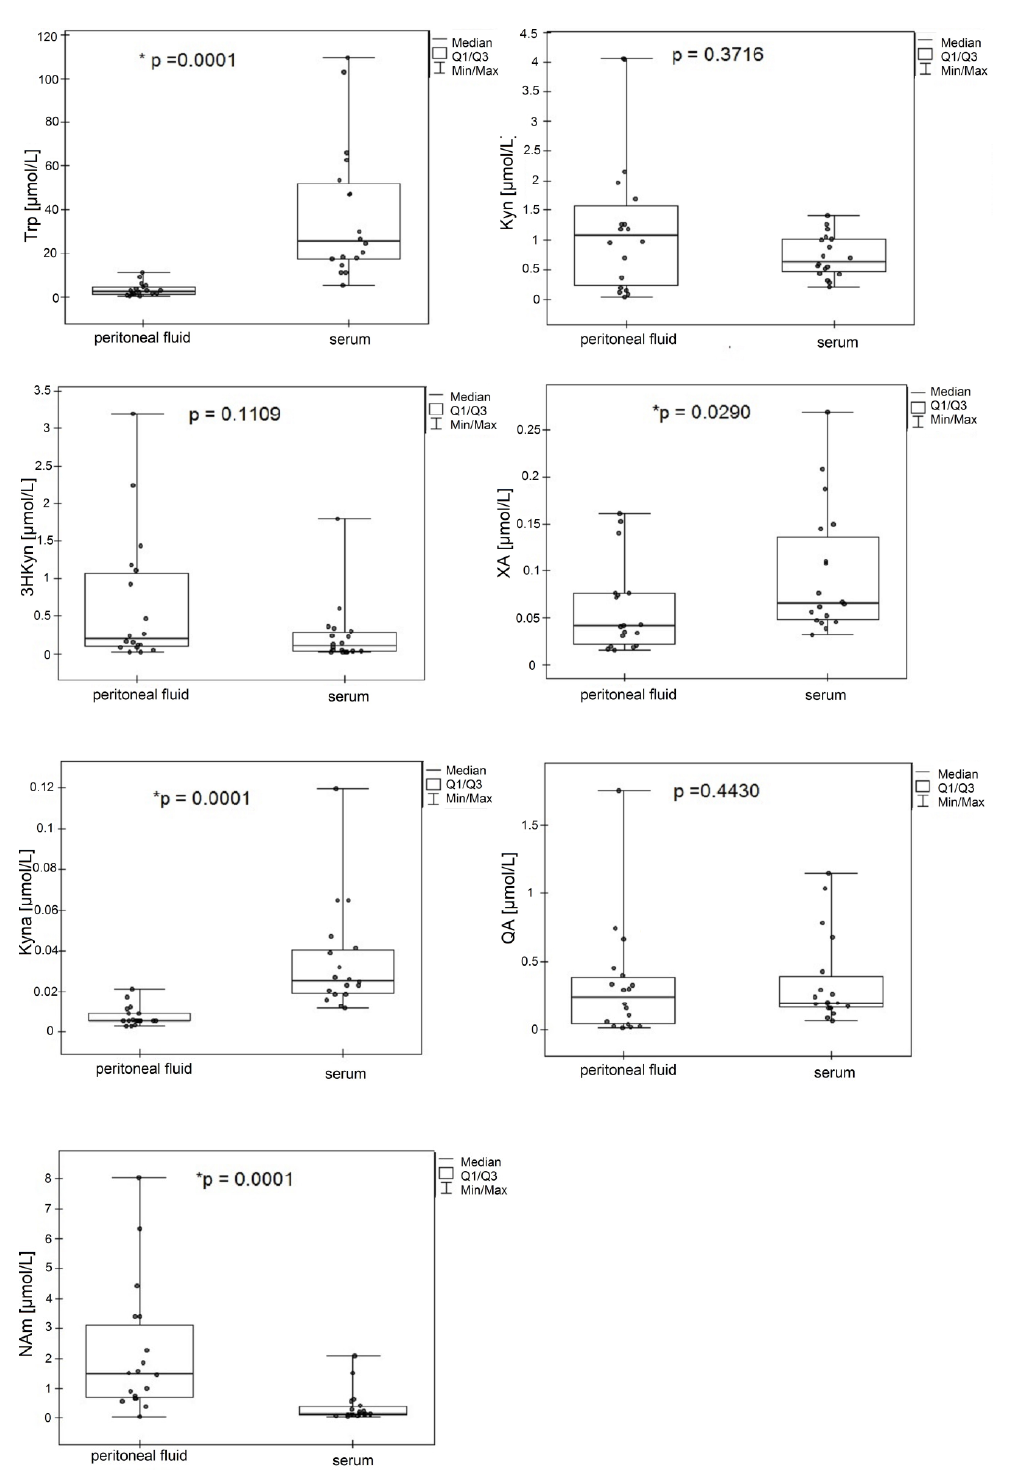
Figure 4. Comparison of concentrations of Trp, Kyn, 3HKyn, XA, Kyna, QA, and NAm determined in the serum and peritoneal fluid from GC patients ( n = 18). * Statistically significant difference between concentration in the serum and peritoneal fluid.